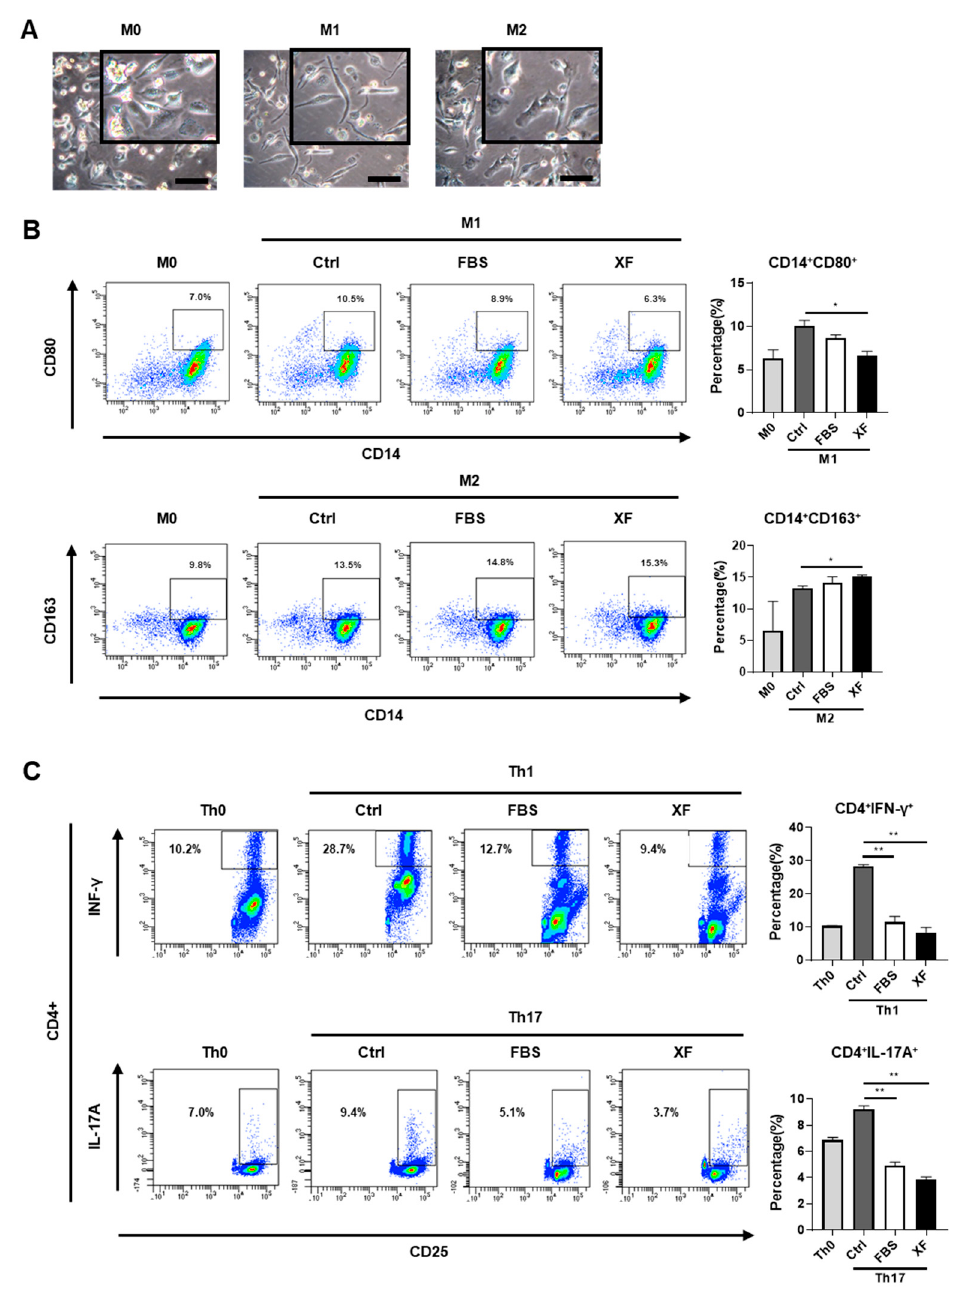
Figure 6. XF-MSCs regulate polarization of macrophages and T helper (Th) cells. ( A – B ) THP-1 cells were incubated with phorbol 12-myristate 13-acetate (PMA) for 24h and further overnight cultured in fresh medium for M0 di ff erentiation. THP-1 derived macrophage (M0) was treated with M1 cytokines (IFN- γ , LPS) or M2 cytokines (IL-4, IL-13) and cultured with or without 10%-MSC (FBS) or XF-MSCs (XF) for 2 days. ( A ) Representative images of M0, M1, and M2. Scale bar, 100 µ m. ( B ) After M1 and M2 induction, M1 (CD14 + CD80 + ), M2 (CD14 + CD163 + ) macrophage markers were measured by flow cytometry. (C) CD4 + T cells were cultured with specific lineage-driving cytokines with or without 10%-MSCs (FBS) or XF-MSCs (XF) for 5 days. The expression of Th1, Th17 specific markers (IFN- γ and IL-17A) from CD4 + T cells was determined by flow cytometry. The results are representative of independent experiments performed at least three times. (* p < 0.05, ** p <